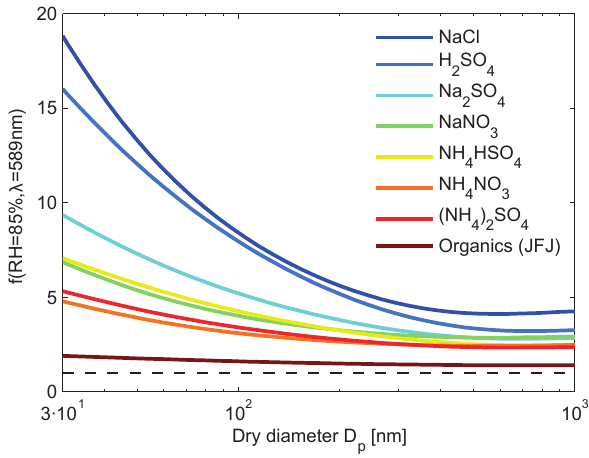
Fig. 2. The scattering enhancement f (RH) at RH = 85% and λ = 589nm vs. dry particle diameter calculated for different in- organic salts (see legend) and for organics (typically found at the Jungfraujoch, JFJ). A monomodal size distribution is assumed ( σ = 1.8). The hygroscopic growth factors were taken from Topping et al. (2005); Sjogren et al. (2008), and the refractive indices were taken from Seinfeld and Pandis (2006) and Nessler et al.